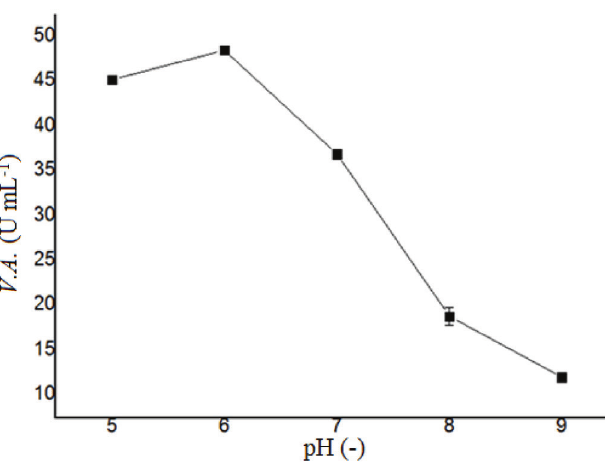
Fig. 3 – Effect of pH on enzyme activity (with temperature 35 °C, alginate concentration 20 g L –1 , rotation rate 120 rpm, and fermentation time 72 h)